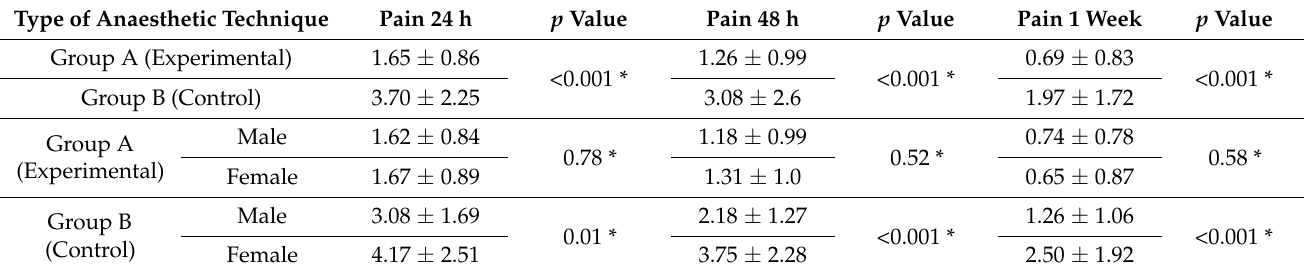
Table 2. Comparison of the mean scores for the degree of pain from 24 h, 48 h and 1 week. Type of Anaesthetic Technique Pain 24 h p Value